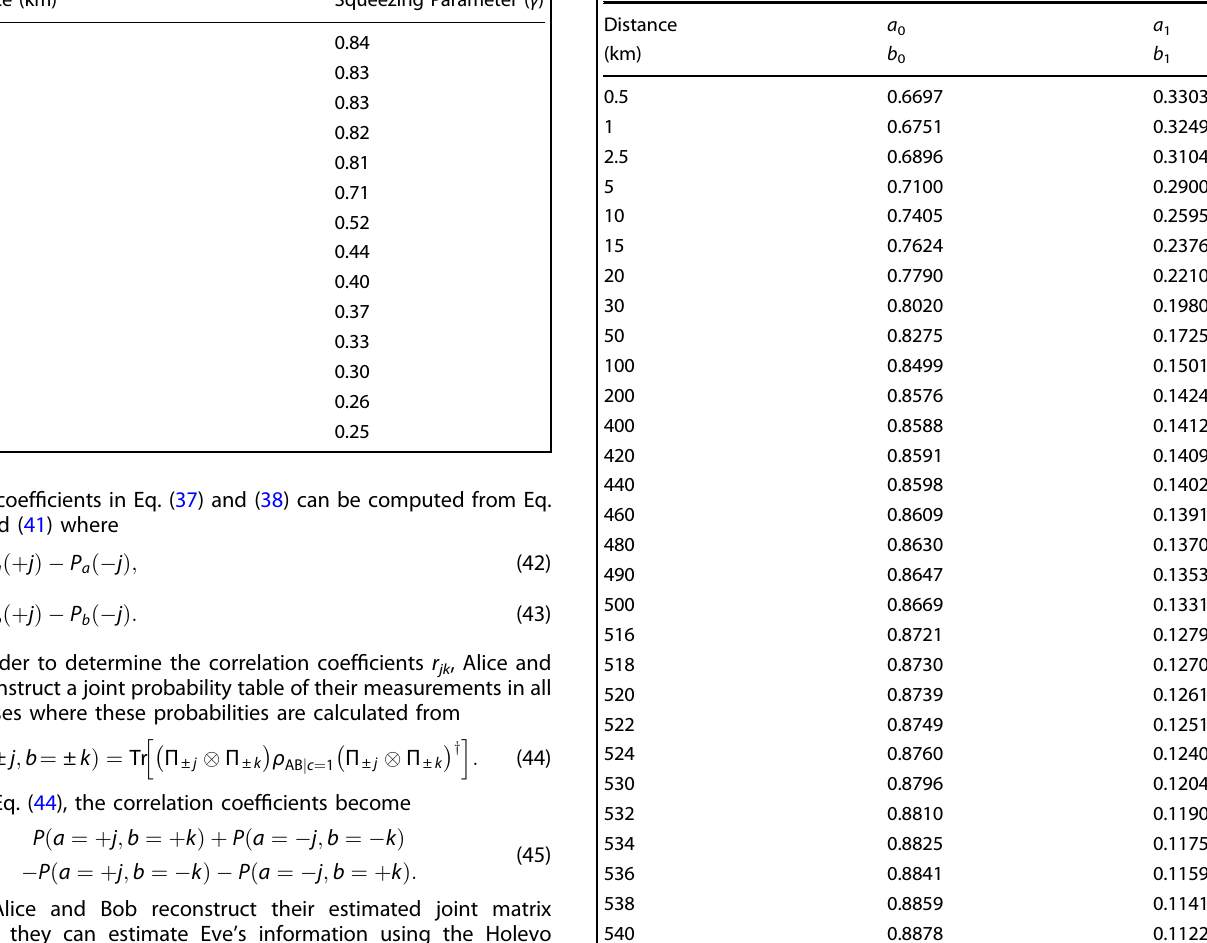
Table 5. The coef fi cients of the single-photon states when the detector dark count rate is 5 × 10 − 8 and with a detector ef fi ciency of